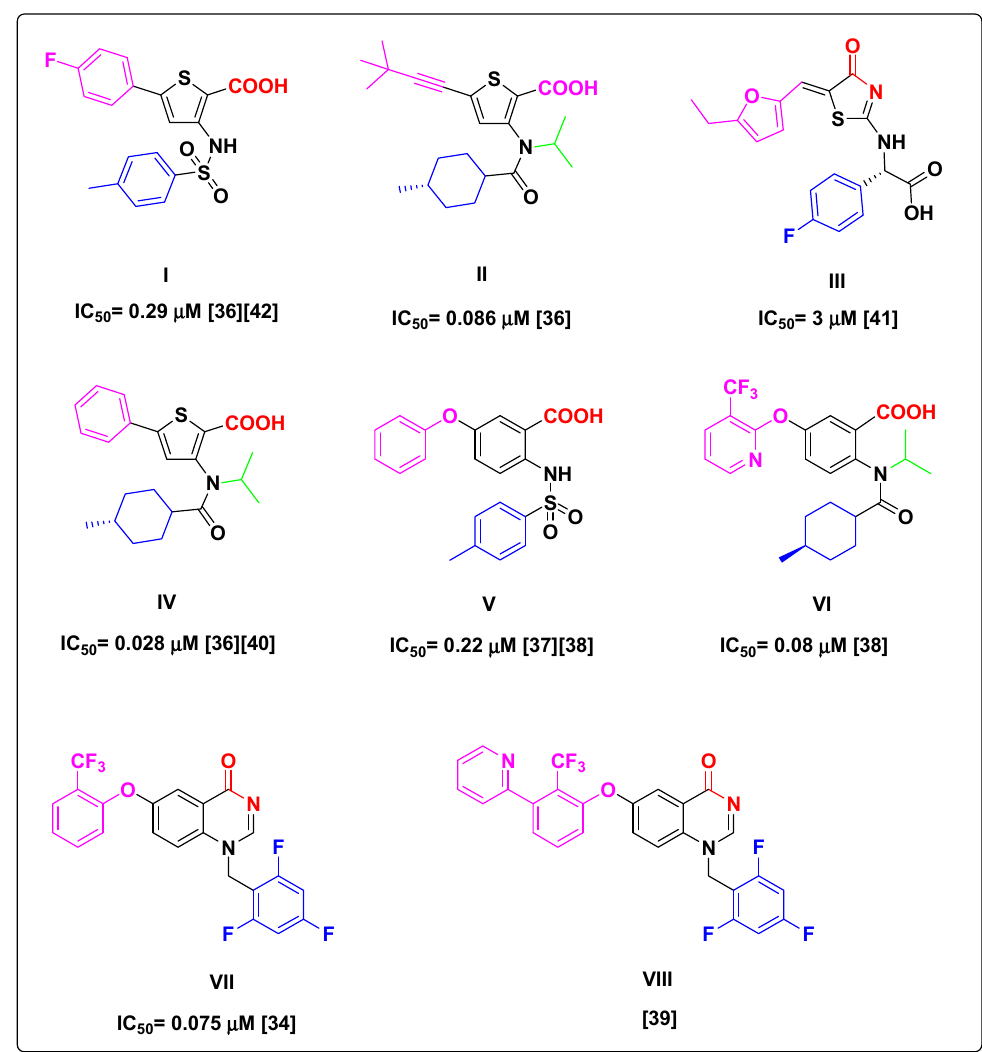
Figure 1. Some reported NS5B TP-2 inhibitors exhibiting promising HCV inhibition. The crystal structure of compounds I, II, III, IV, V, VII, and VIII bound to TP-2 binding site of NS5B were re- ported; PDB codes: 2D3Z, 4EO6, 2HWI, 2GIR, 4J08, 4JTW, and 4JU2, respectively. Table 1. Reported EC 50 and calculated lipophilic and solubility parameters for compounds I - VIII . Compound